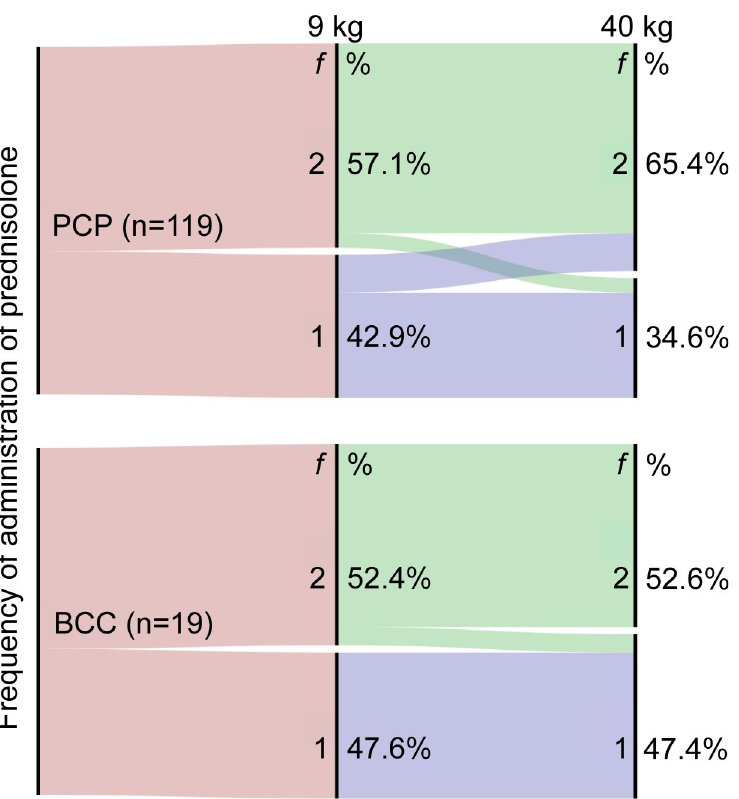
Fig 6. Clinicians administer glucocorticoids once daily or twice daily with similar frequency in clinical scenarios. Alluvial plots showing intended frequency of administration (f) of prednisolone by board-certified clinicians (BCC) (bottom) and those in primary care practices (PCP) (top) in two clinical scenarios when asked to indicate their preferred starting dose of prednisolone for treatment of 2 dogs of different weights, indicated by ‘9 kg’ and ‘40 kg’ over the corresponding nodes. Respondents indicated they administered prednisolone either once daily (‘1’) or twice daily (‘2’) in these clinical scenarios, with some respondents making a different choice between the 2 scenarios.